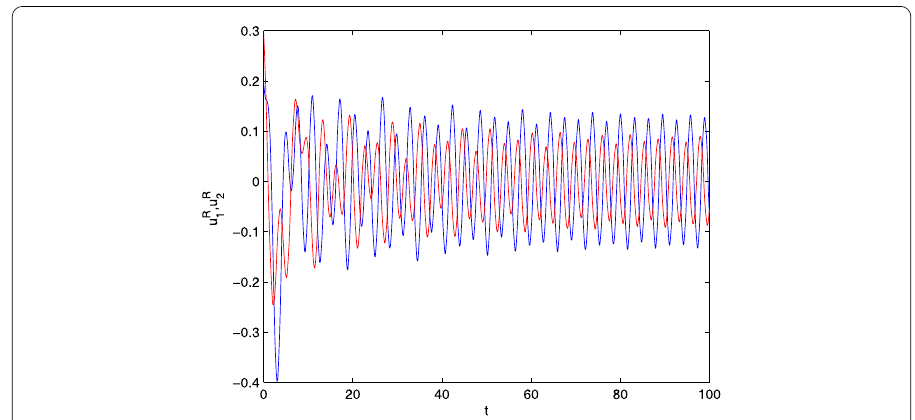
Figure 1 The anti-periodic solution of model (5.1): t – u R 1 and t – u R 2 . The blue line stands for u R 1 and the red line stands for u R